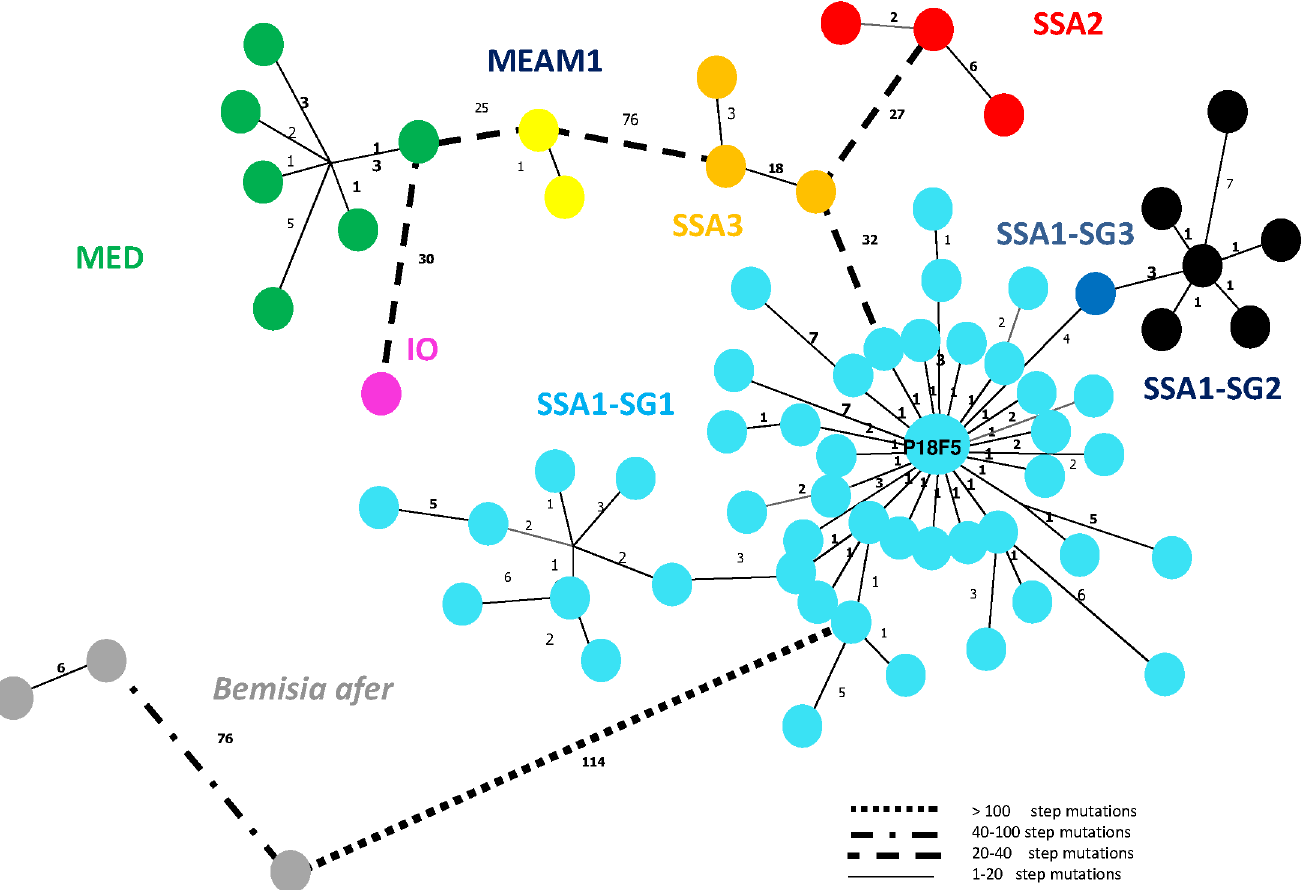
Fig 3. Minimum spanning network for B . tabaci SSA1, SSA2, SSA3, MEAM1, MED, Indian Ocean and B . afer species sampled from cassava crops and weeds in Central African Republic. Plain and dashedlines betweencircles represent mutational steps. Haplotypeswith the same colored circle were assignedto the same